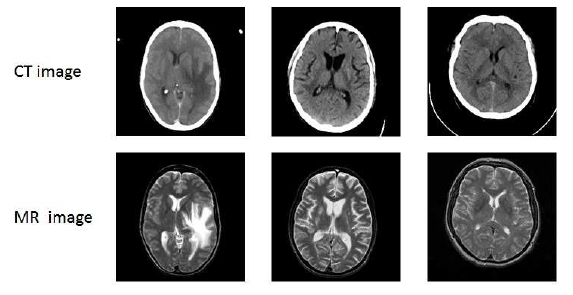
Figure 6. Original CT and MR